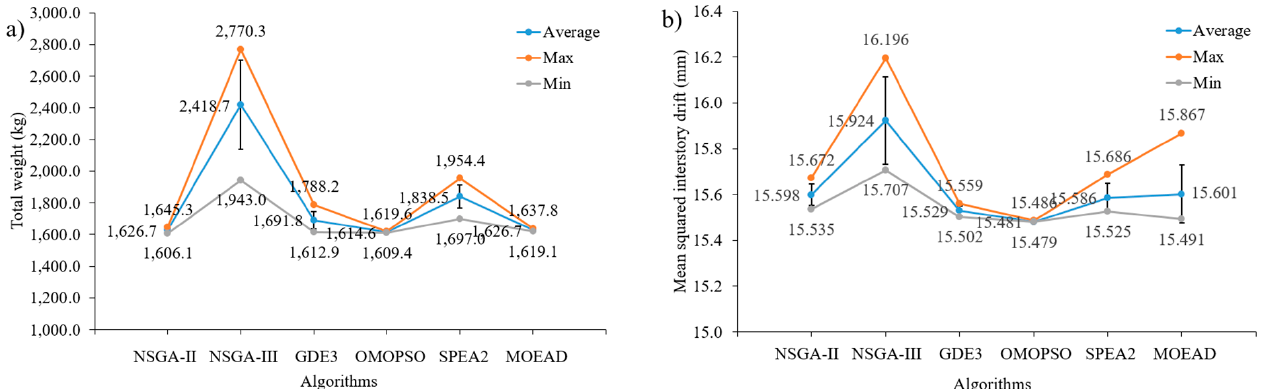
Figure 11. Spread illustration of the optimal solutions in the 72-bar truss regarding the ( a ) first objective; ( b ) second objective.